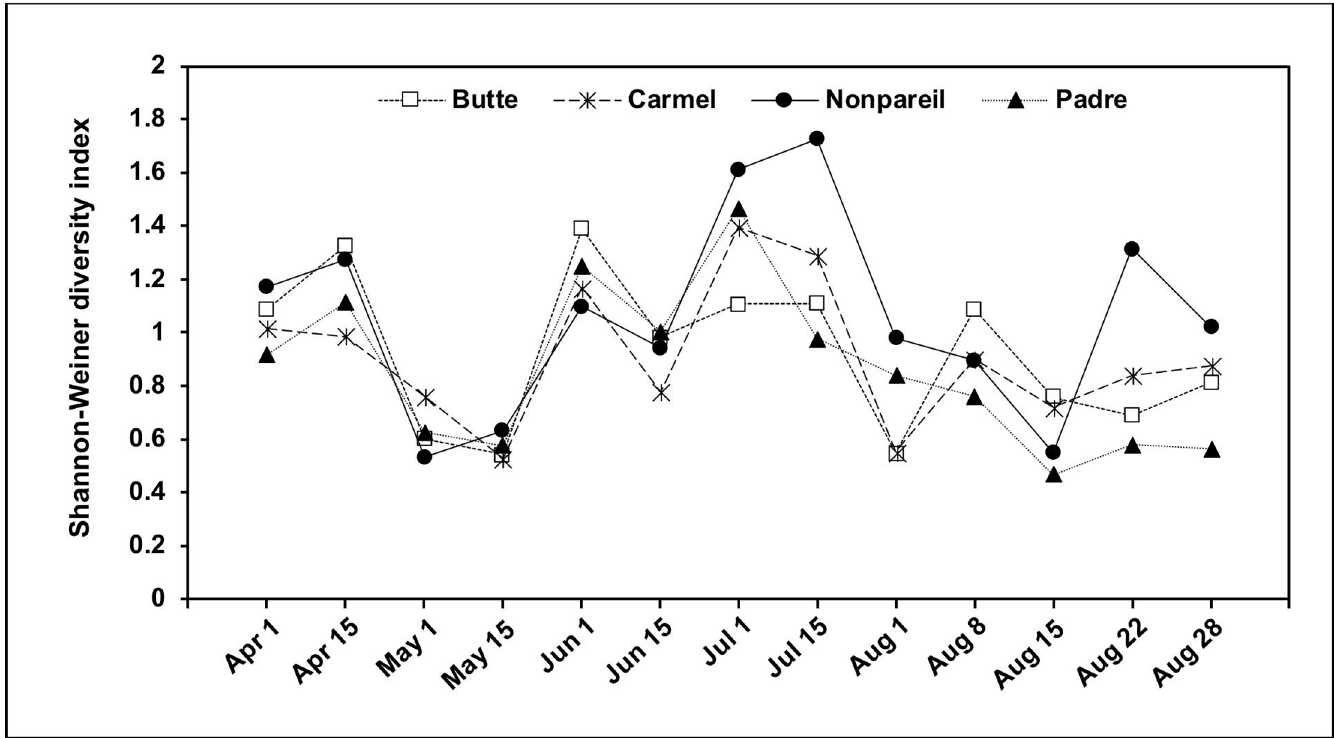
Fig 2. Shannon-Weiner diversity indices of fungal species detected in four almond cultivars during the course of the study in an experimental orchard at the Kearney Agricultural Research and Extension Center in Parlier, CA.